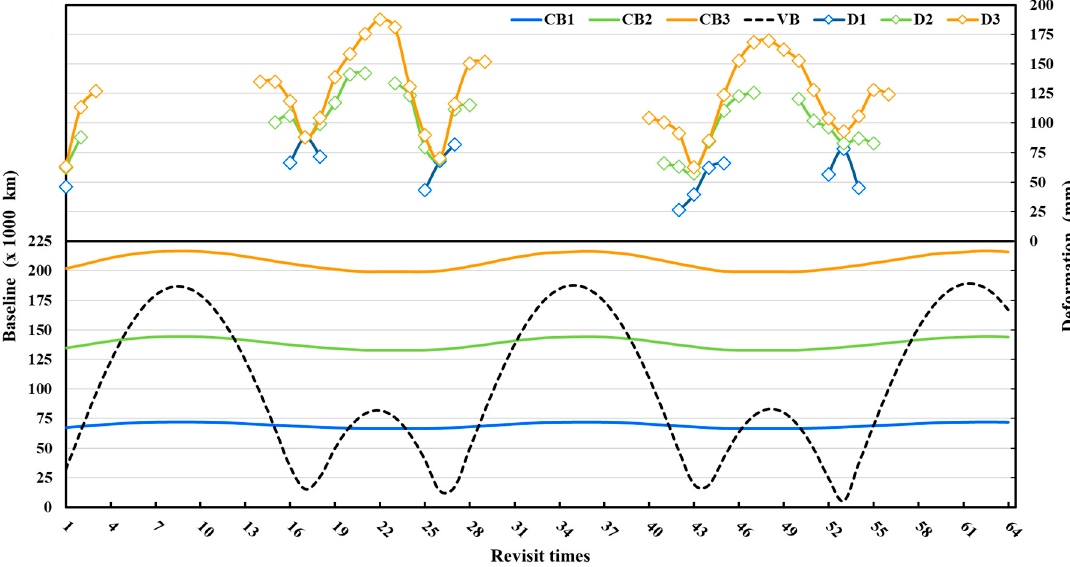
Figure 13. The three CB lines represent the maximum value of the critical baseline, and CB1, CB2, and CB3 have a signal bandwidth of 100, 200, and 300 MHz, respectively; VB represents the vertical baseline; and D1, D2, and D3 represent the tidal deformation span in an EIC.